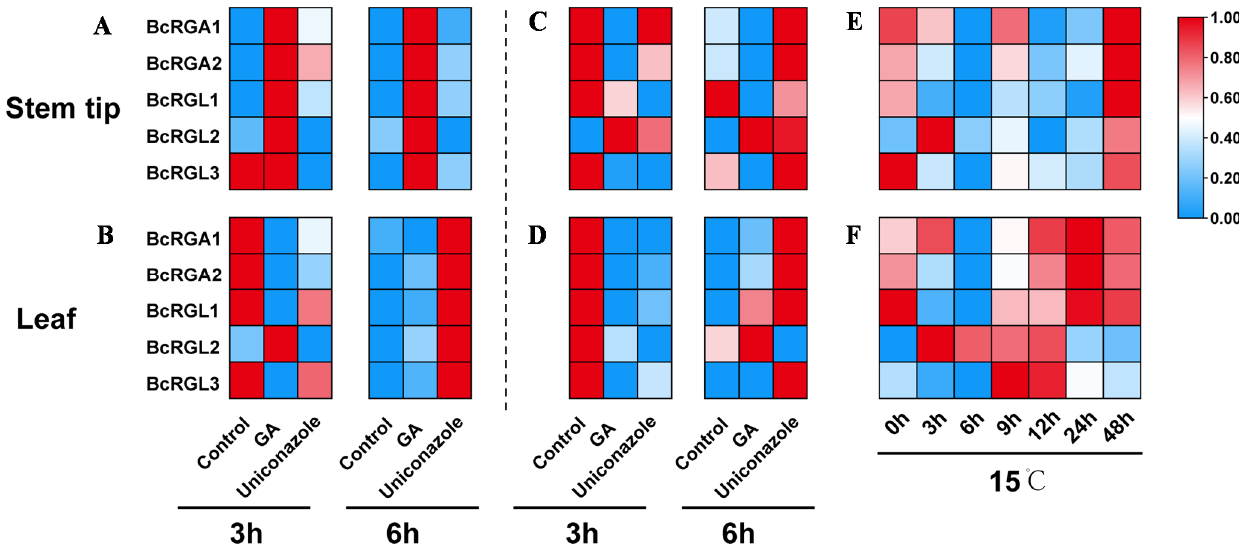
Figure 3. Expression profiles of flowering Chinese cabbage DELLA genes under gibberellin A3 (GA 3 ), uniconazole, and 15 °C treatments. ( A , B ): two-true-leaf treatment, ( C – F ): three-true-leaf treatment. Each column displays normalization independently.